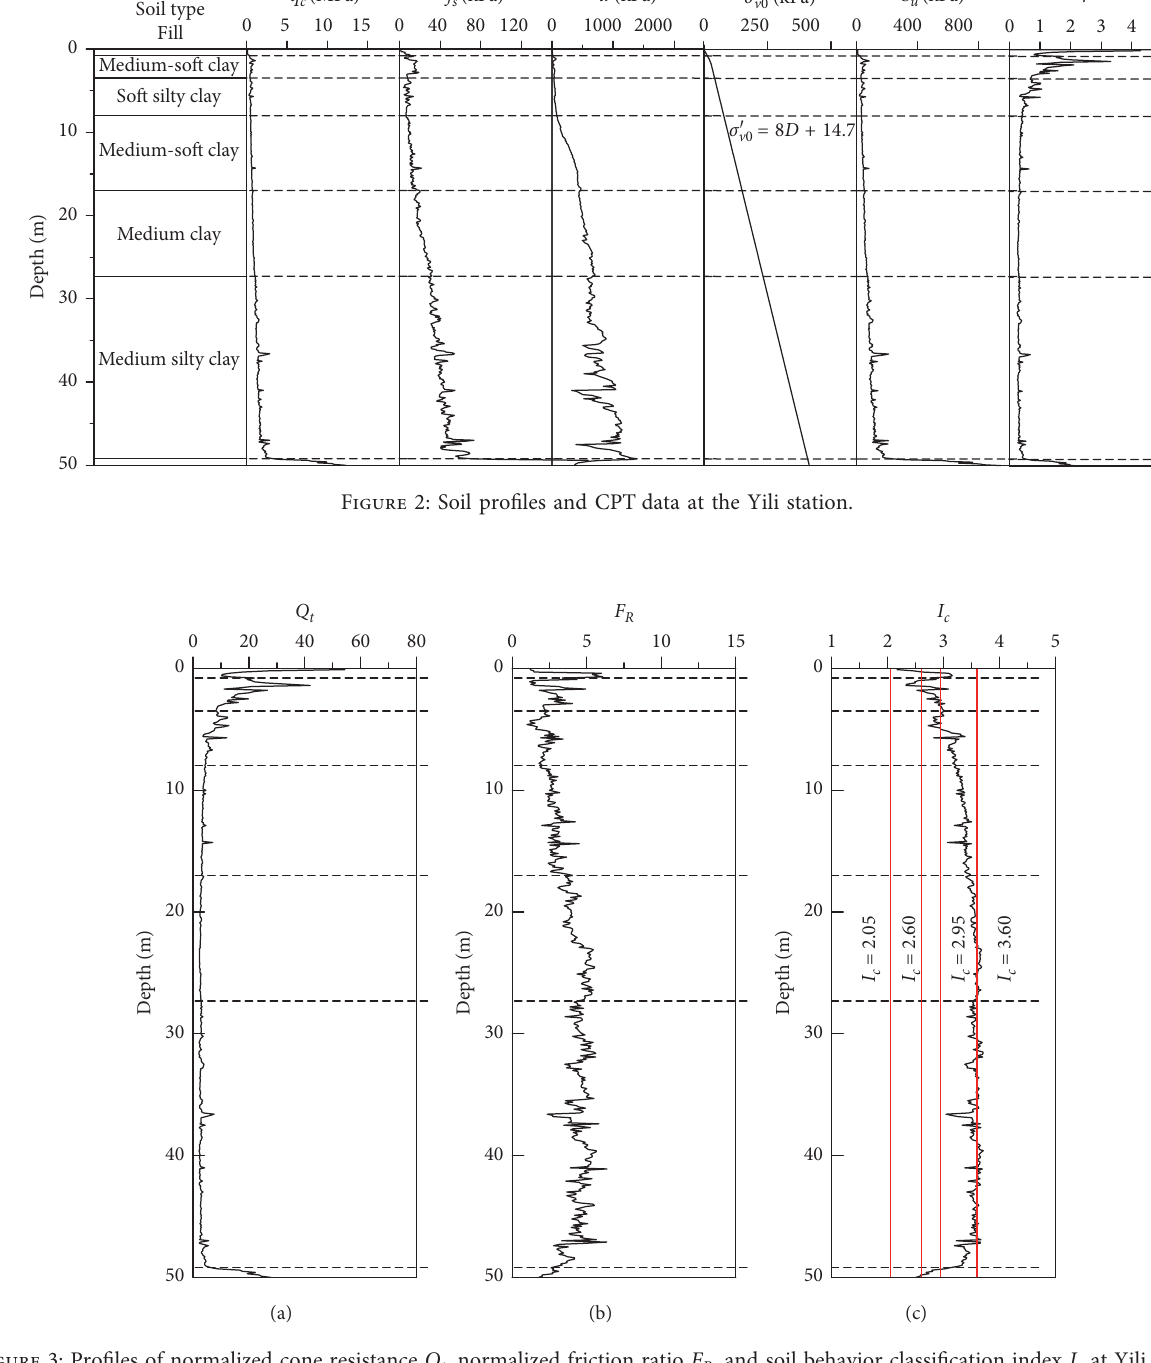
Figure 3: Profiles of normalized cone resistance Q t , normalized friction ratio F R , and soil behavior classification index I c at Yili